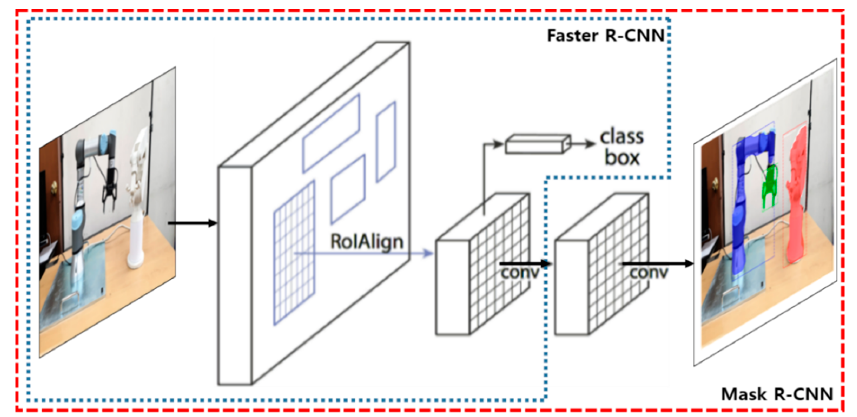
Figure 5. Mask R-CNN-based segmentation of manufacturing facilities. Mask R-CNN extends Faster R-CNN [40] by adding a branch for predicting segmen- tation masks on each region of interest (RoI), in parallel with the existing branch for clas- sification and bounding box regression [37]. The mask branch is a fully convolutional net- work (FCN) applied to each RoI, predicting a segmentation mask in a pixel-to-pixel man- ner. Mask R-CNN has two stages for instance segmentation. The first stage scans the im- age and generates region proposals. The second stage classifies the proposals and gener- ates bounding boxes and masks. In the first stage, the region proposal network (RPN), like Faster R-CNN, is used to predict the bounding box for the object. However, in Mask R- CNN, RoIAlign was used instead of RoIPool for accurate segmentation and fixing misa- lignment. Mask R-CNN defines a multi-task loss on each sampled RoI as follows (Equation (1)). L (cid:3404) (cid:1838) (cid:3030)(cid:3039)(cid:3046) (cid:3397) (cid:1838) (cid:3029)(cid:3042)(cid:3051) (cid:3397) (cid:1838) (cid:3040)(cid:3028)(cid:3046)(cid:3038) (1) The classification loss (cid:1838) (cid:3030)(cid:3039)(cid:3046) and the bounding-box loss (cid:1838) (cid:3029)(cid:3042)(cid:3051) (Equation (2)) are iden- tical as those defined in Faster R-CNN [40] as follows. (cid:1838) (cid:3030)(cid:3039)(cid:3046) (cid:3397) (cid:1838) (cid:3029)(cid:3042)(cid:3051) (cid:3404) (cid:1838)(cid:4666)(cid:1868),(cid:1873),(cid:1872) (cid:3048) ,(cid:1874)(cid:4667) (cid:3404) (cid:1838) (cid:3030)(cid:3039)(cid:3046) (cid:4666)(cid:1868),(cid:1873)(cid:4667) (cid:3397) λ(cid:4670)(cid:1873) (cid:3410) 1(cid:4671)(cid:1838) (cid:3039)(cid:3042)(cid:3030) (cid:4666)(cid:1872) (cid:3048) ,(cid:1874)(cid:4667) (2) where p and t represent the size and position of the predicted classes and bounding box, and u and v represent the size and position of the real class and bounding box. Finally, the mask loss (cid:1838) (cid:3040)(cid:3028)(cid:3046)(cid:3038) is defined as the average binary cross-entropy. 3.2.2. Depth Prediction By conducting the instance segmentation mentioned above, it is possible to calculate 2D spatial relations, such as relative positions between real objects. However, since the depth information is unknown, a 3D spatial relation cannot be derived, which can cause visual mismatch and occlusion problems. To calculate the 3D spatial relationships be- tween objects from the AR view, depth information must be predictable. Note that mobile AR also utilizes a single image so that it cannot percept depth information from the single image without AR markers. In this study, depth information was predicted through an hourglass network by training MageDepth Dataset [38,39]. Depth prediction aims to re- cover depth information from a single RGB image taken from a camera. As shown in Fig- ure 6, the hourglass network consists of a series of convolutions using a variant of the inception model and down-sampling, followed by a series of convolutions and up-sam- pling, interleaved with skip connections that add back features. The symmetric shape of the network resembles an hourglass. Through this process, the depth information of the